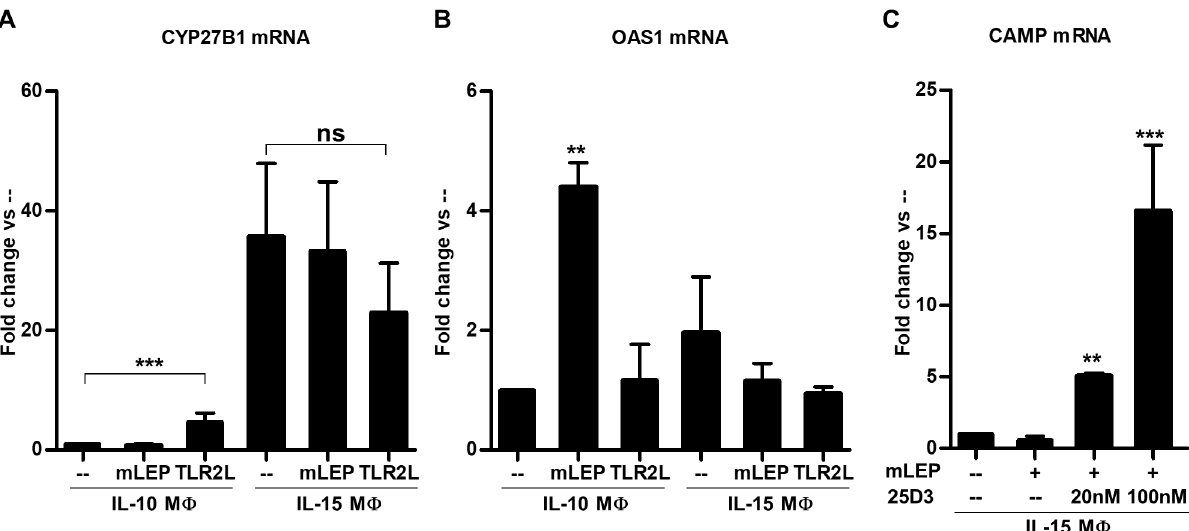
Fig 4. IL-15 M F and IL-10 M F differentially respond to M . leprae infection. IL-15 M F and IL-10 M F were infected with M . leprae or stimulated with TLR2L for 24 hours. ( A ) CYP27B1 and ( B ) OAS1 gene expression levels were assayed by quantitative PCR. ( C ) IL-15 M F were infected with M . leprae and supplemented with 20nM 25D 3 , 100nM 25D 3 , or vehicle control for 24 hours. Cathelicidin (CAMP) gene expression was assayed by qPCR. Data are shown as mean fold change ± SEM, n = 3. Statistical significance was determined using one-way ANOVA. ( (cid:3) p (cid:20) 0.05, (cid:3)(cid:3) p (cid:20) 0.01, (cid:3)(cid:3)(cid:3) p (cid:20) 0.001).